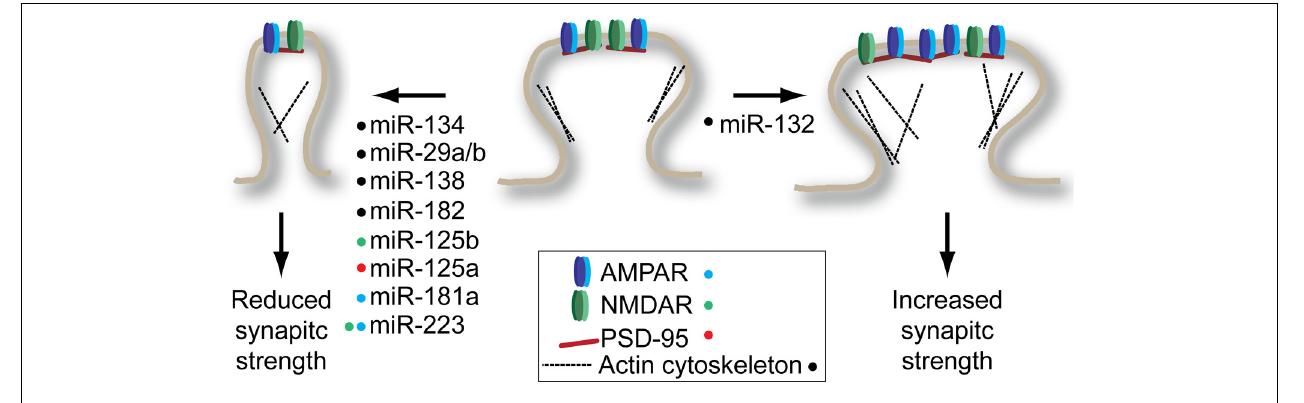
FIGURE 1 | miRNAs regulate structural and synaptic plasticity by targeting synaptic spine proteins. Many miRNAs promote decrease in spine volume and/or glutamate receptor density (left) while only miR-132 has